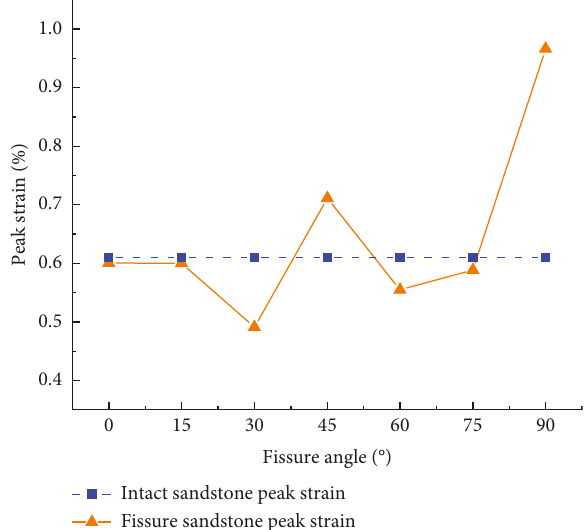
Figure 6: Peak strain of the fissured sandstone versus fissure